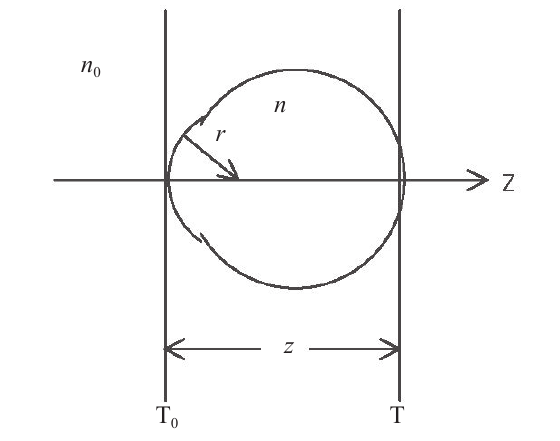
Figure 1. The reduced eye as a defined optical system. The length is z , the radius of curvature of the refracting surface is r , the refractive index outside the system is n and inside the 0 system is n . The optical system has a longitudinal axis, Z and is bound by an entrance plane T immediately in front of the 0 refracting surface and an exit plane T immediately in front of the retinal